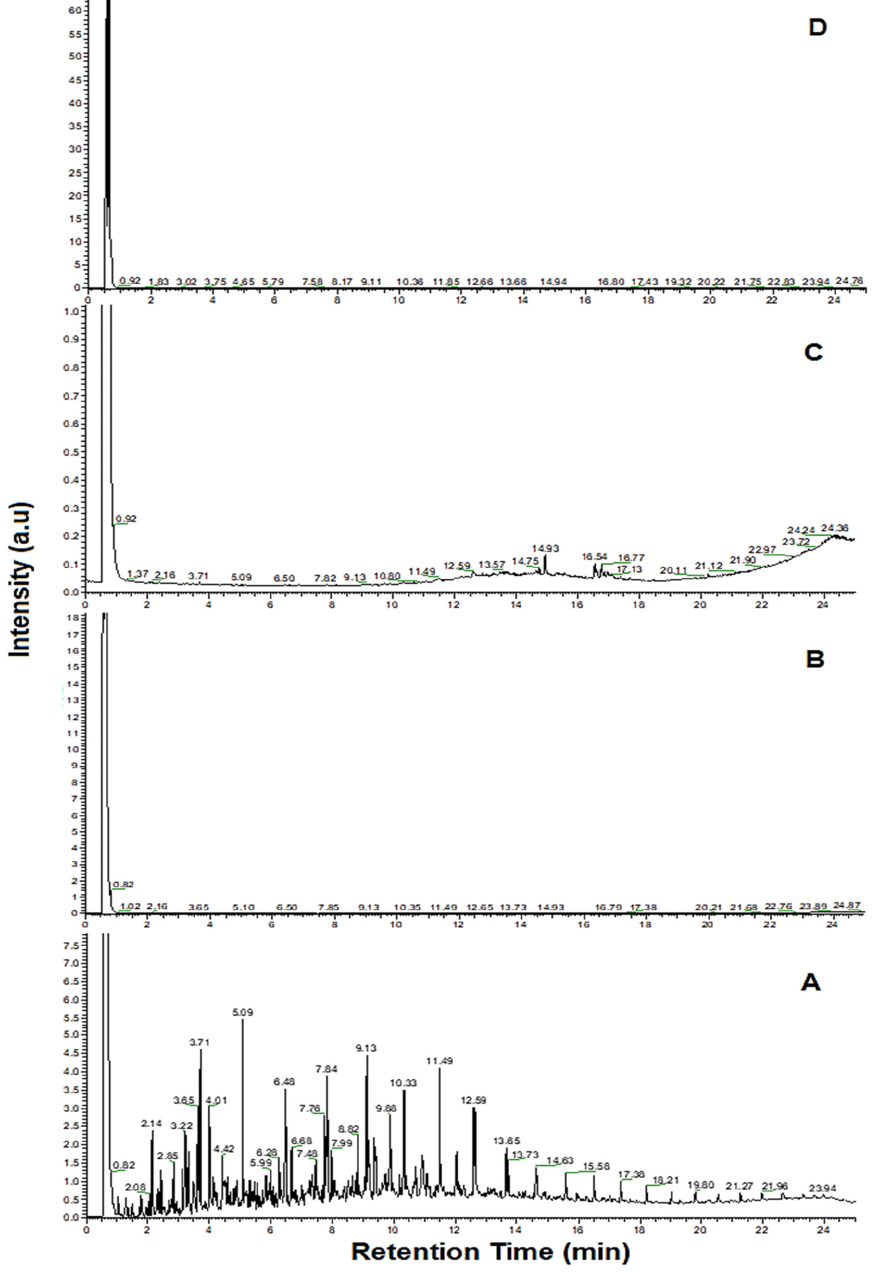
Figure 9. GC-MS chromatograms of ( A ) refinery wastewater sample, refinery wastewater treated by ( B ) adsorption over AC, ( C ) photo-oxidation by UV/TiO 2, ( D ) integrated photo-oxidation and adsorption over TiO 2 /AC.